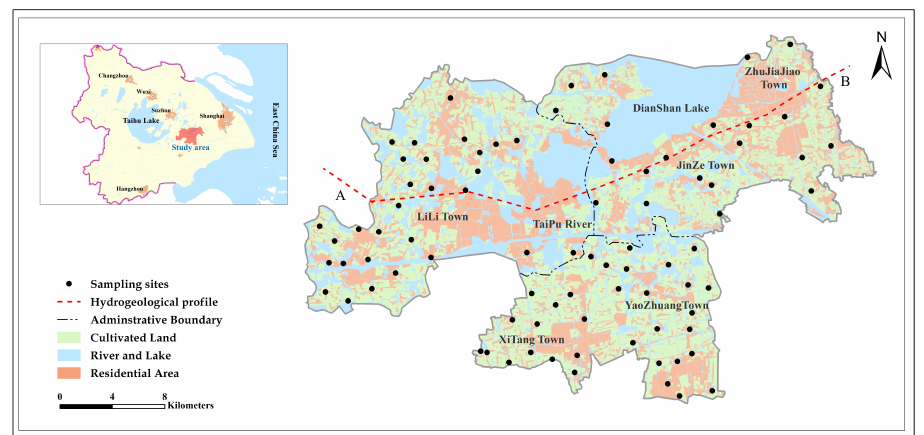
Figure 1. Location of the pilot promoter region of Yangtze River Delta integration demonstration zone and distribution of groundwater sampling sites with the land-use.